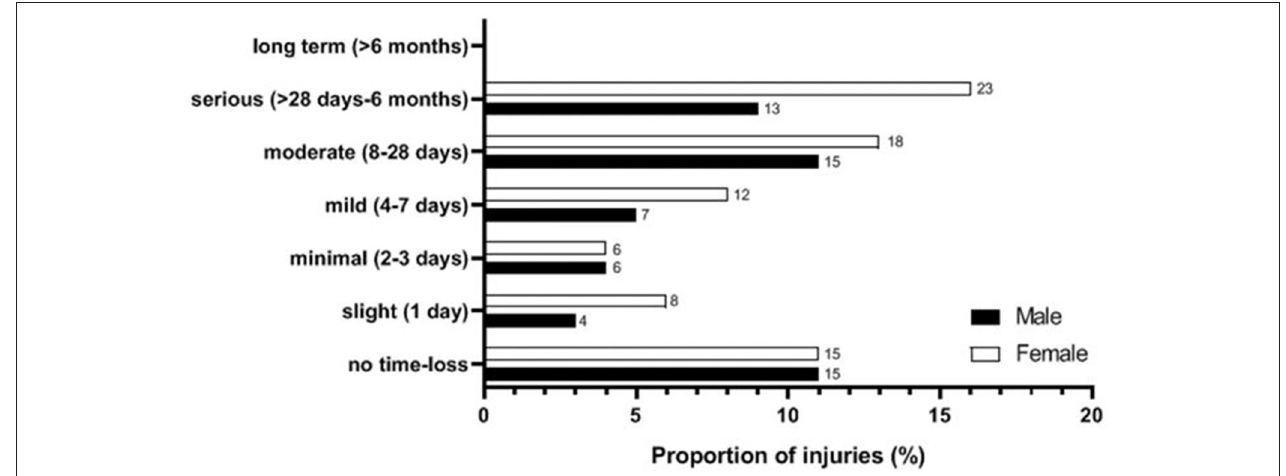
FIGURE 1 | Proportion of running-related injuries (RRI) incurring time loss from distance running in days. NB, Due to rounding, not all numbers add up correctly.